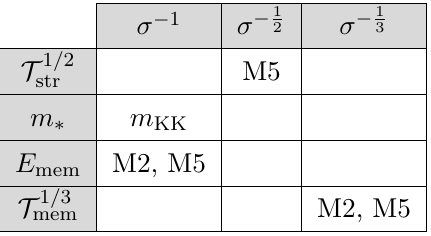
Table 12 . Mass scalings along the flows generated by the string with charges (1 , 1 , 0 , 0 , 0 , 0 , 0) .